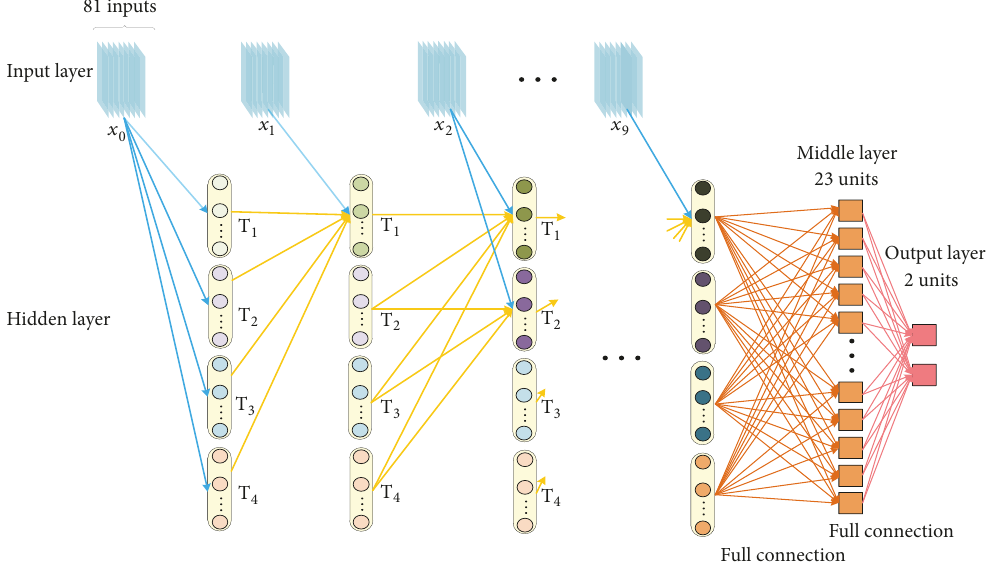
Figure 2: The network structure of CW-RNN. Bias units are omitted to simplify the visualization network.